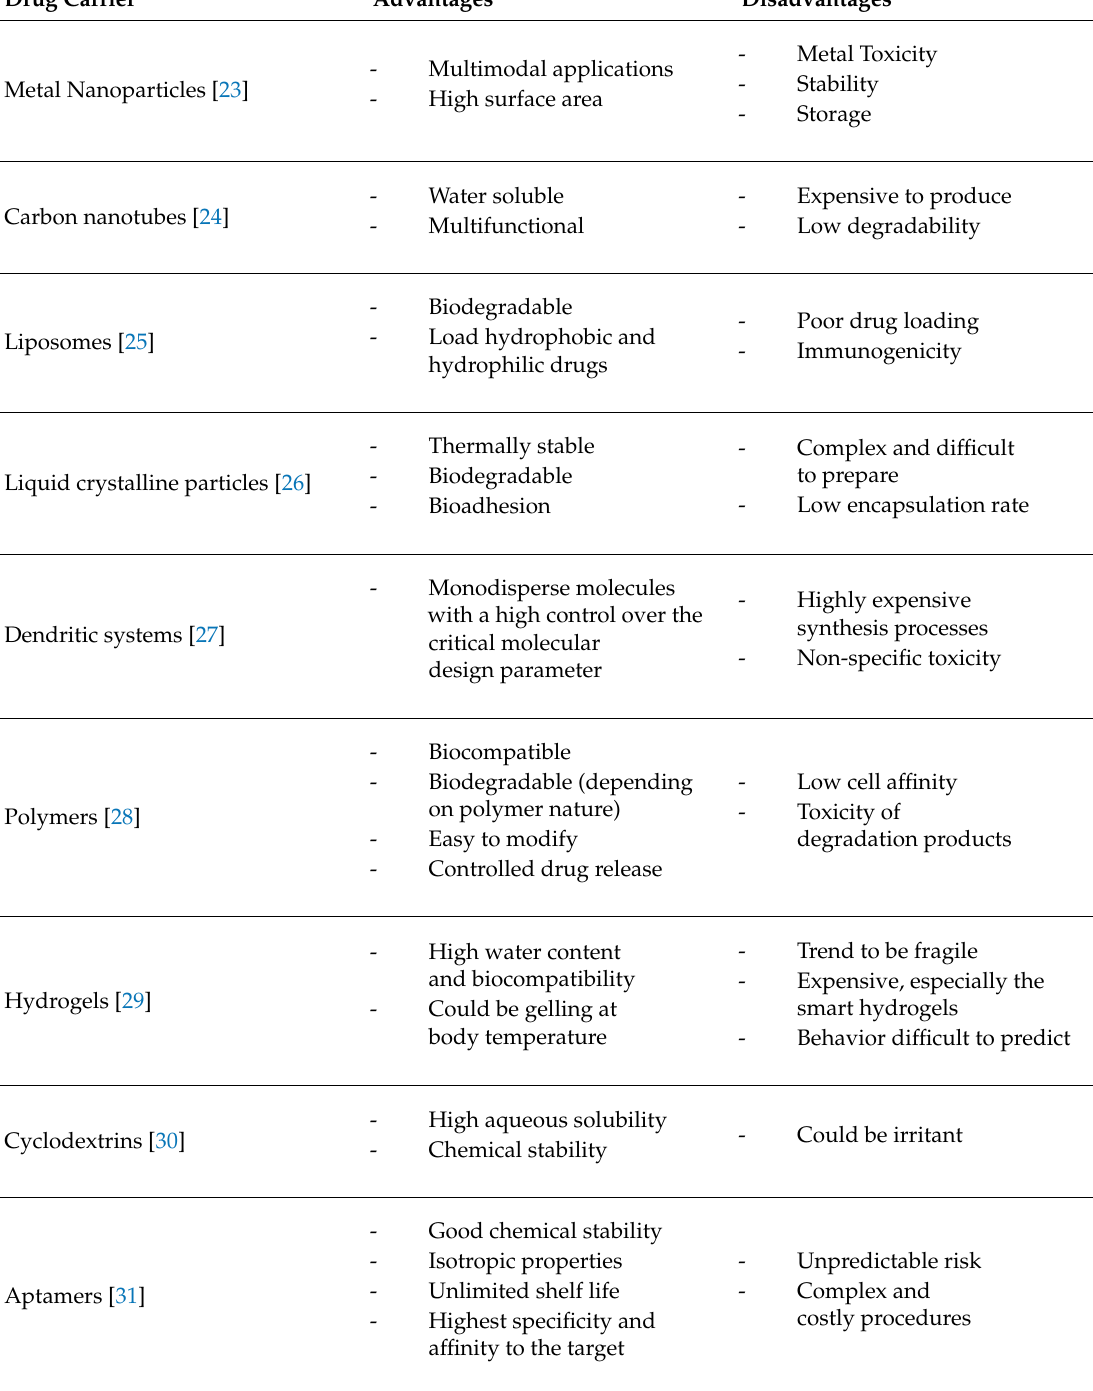
Table 1. Advantages and disadvantages of di ff erent nanostructures as